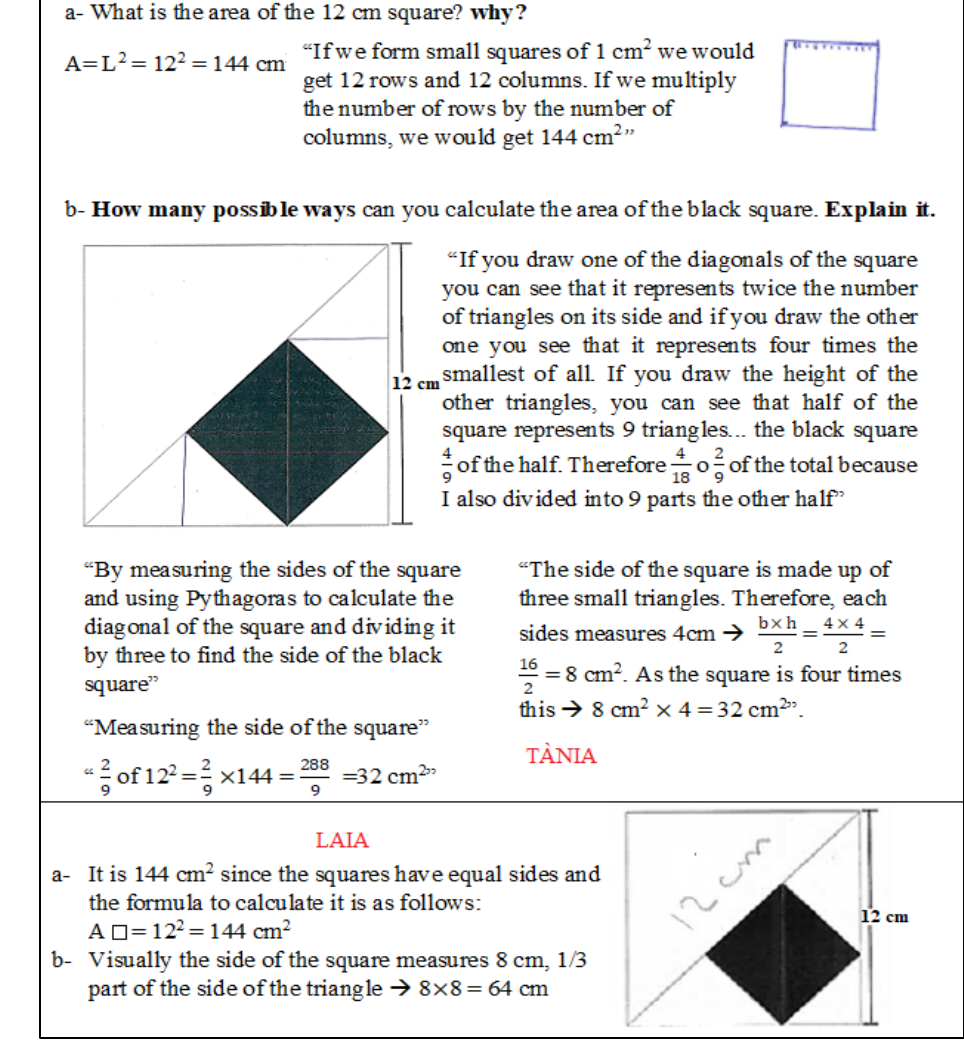
Figure 3. Figure accompanying Task 8.